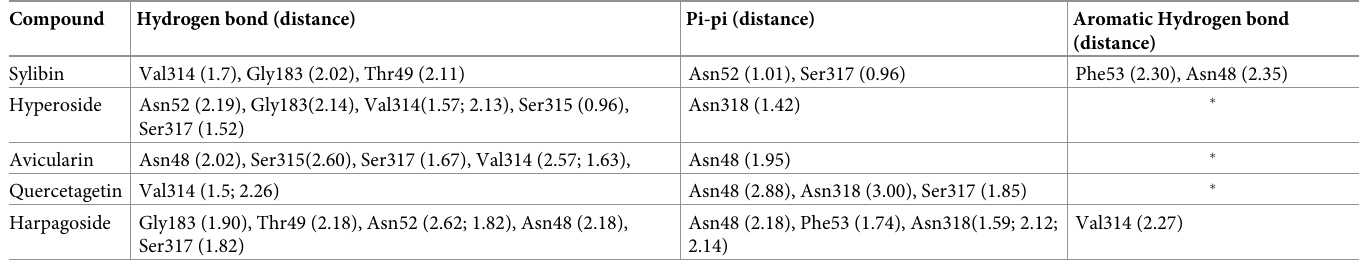
Table 1. Intermolecular interaction of protein-ligand complexes following molecular docking.